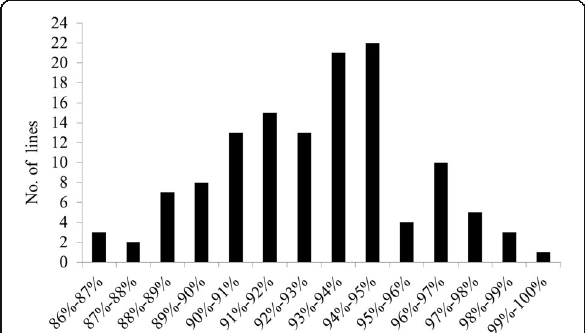
Fig. 2 Distribution of the recovery ratio of the recurrent parent genome in the BC 3 F 1 population